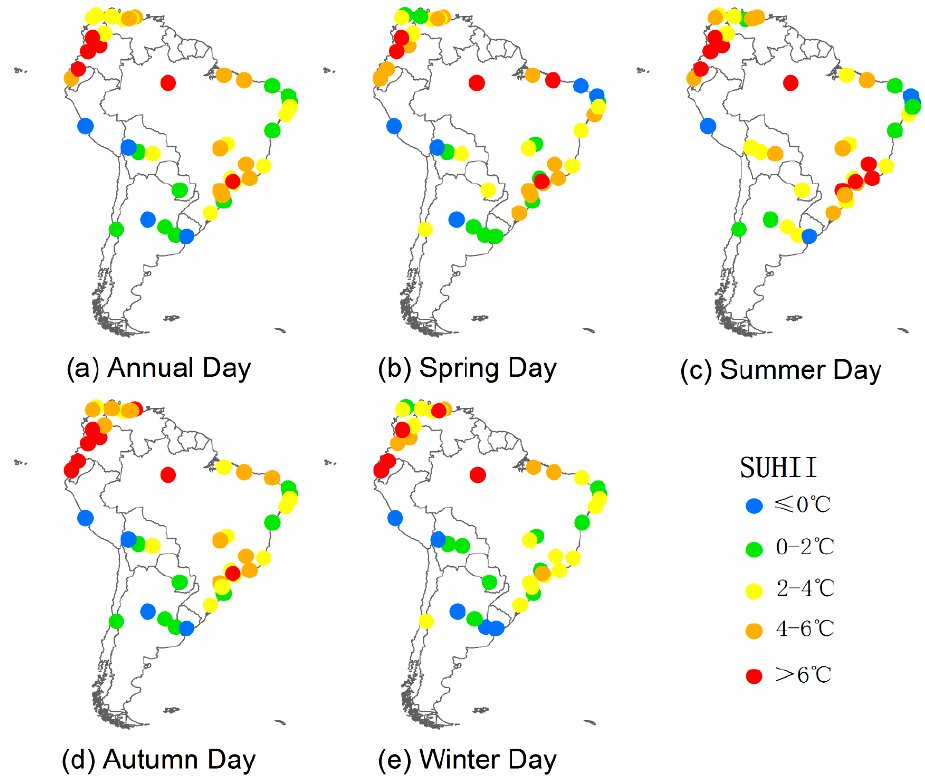
Figure 3. The daytime surface urban heat island intensity (SUHII) for each city in South America.